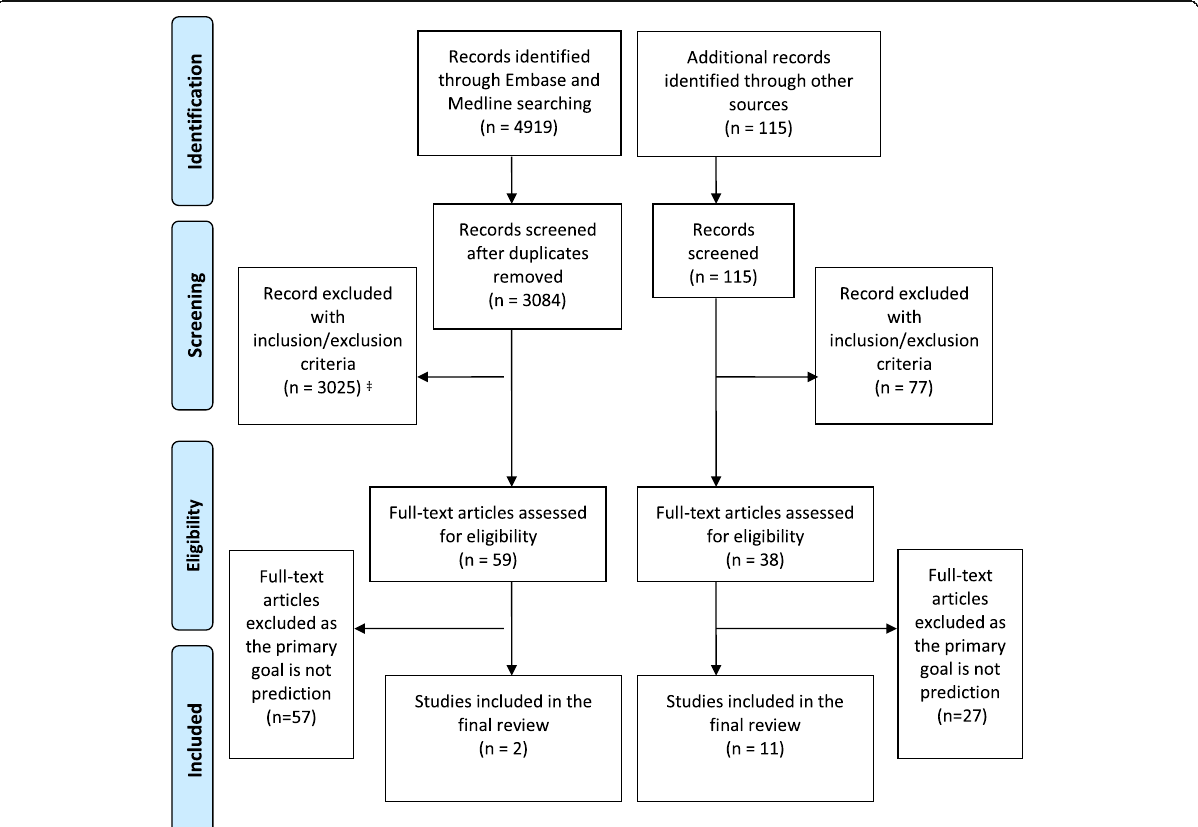
Fig. 1 PRISMA flow diagram. ‡ The majority of papers excluded at this stage did not meet our first inclusion criterion: that is, they did not focus on prediction under hypothetical interventions; these papers either did not use prediction models at all, or only used prediction modelling to enrich causal